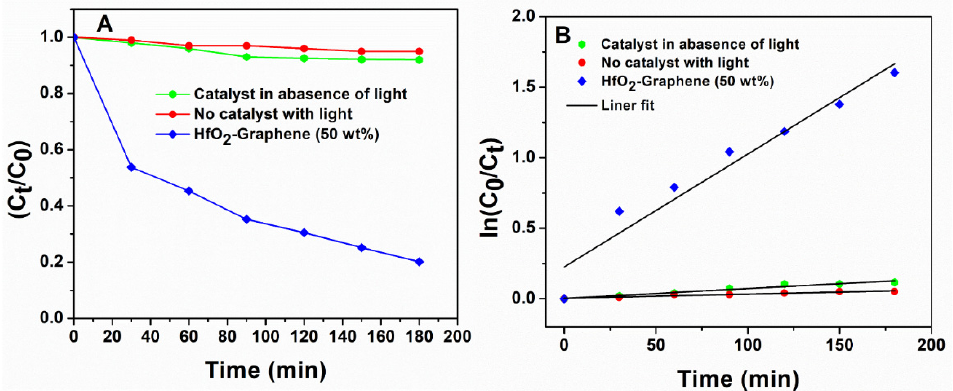
Figure 9. Photocatalytic efficiency of tetracycline degradation as a function of irradiation time under UV light using HfO 2 -graphene ( A ). Rate of degradation of tetracycline under UV light ( B ).